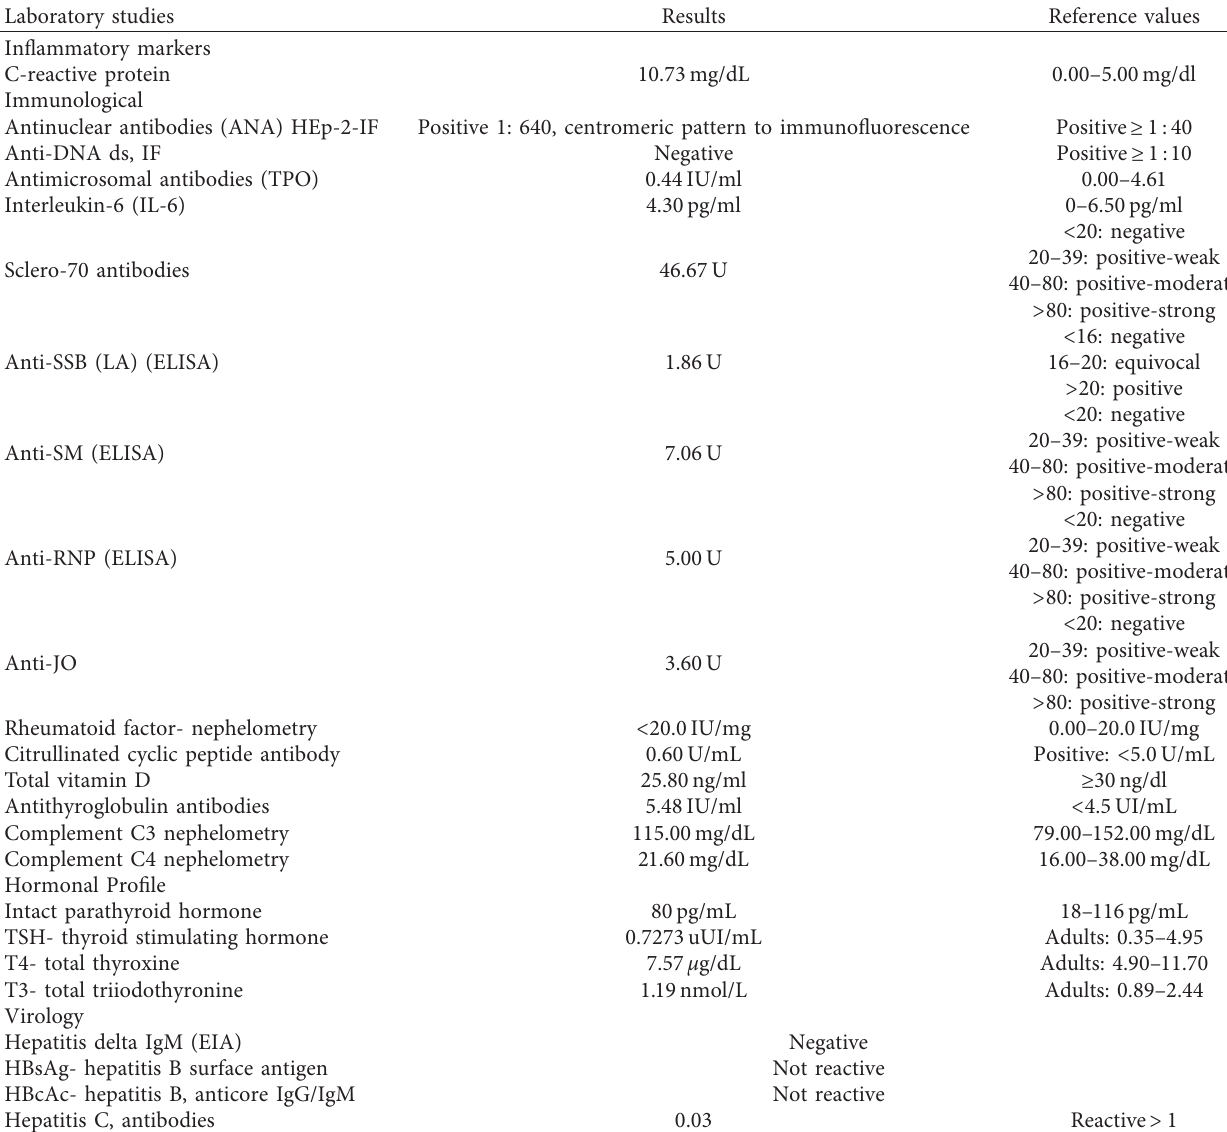
Table 1: Laboratory values.